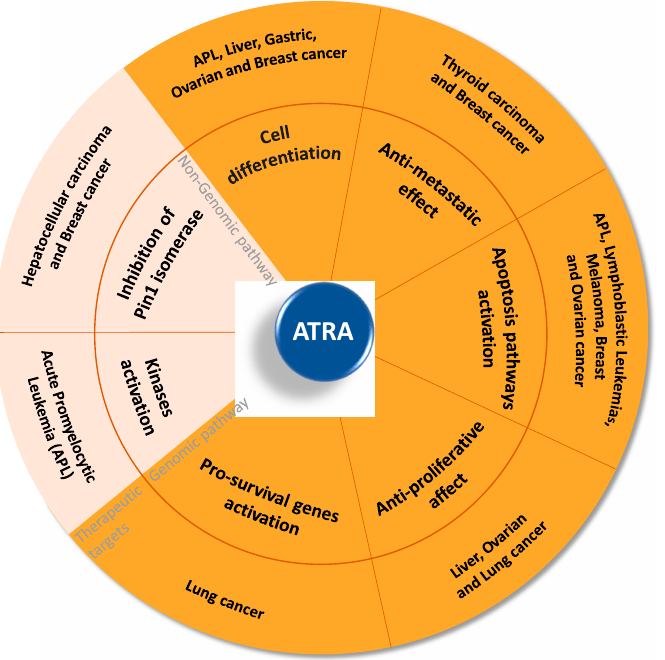
Figure 3. Pleiotropic effects of ATRA in cancer. The image schematically represents how ATRA affects multiple processes by genomic (orange) and non-genomic pathways (pink). Moreover, the image highlights the therapeutic targets for each process.